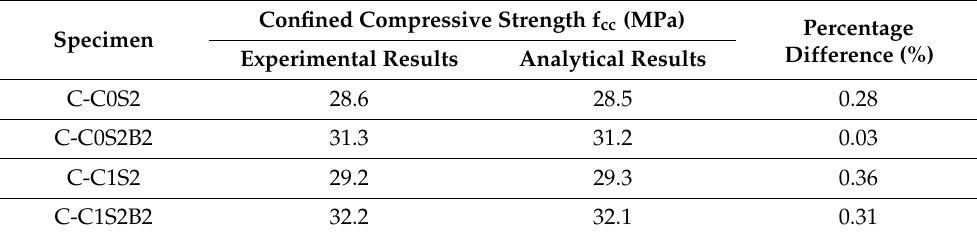
Table 6. Comparison of experimental and analytical confined compressive strength.